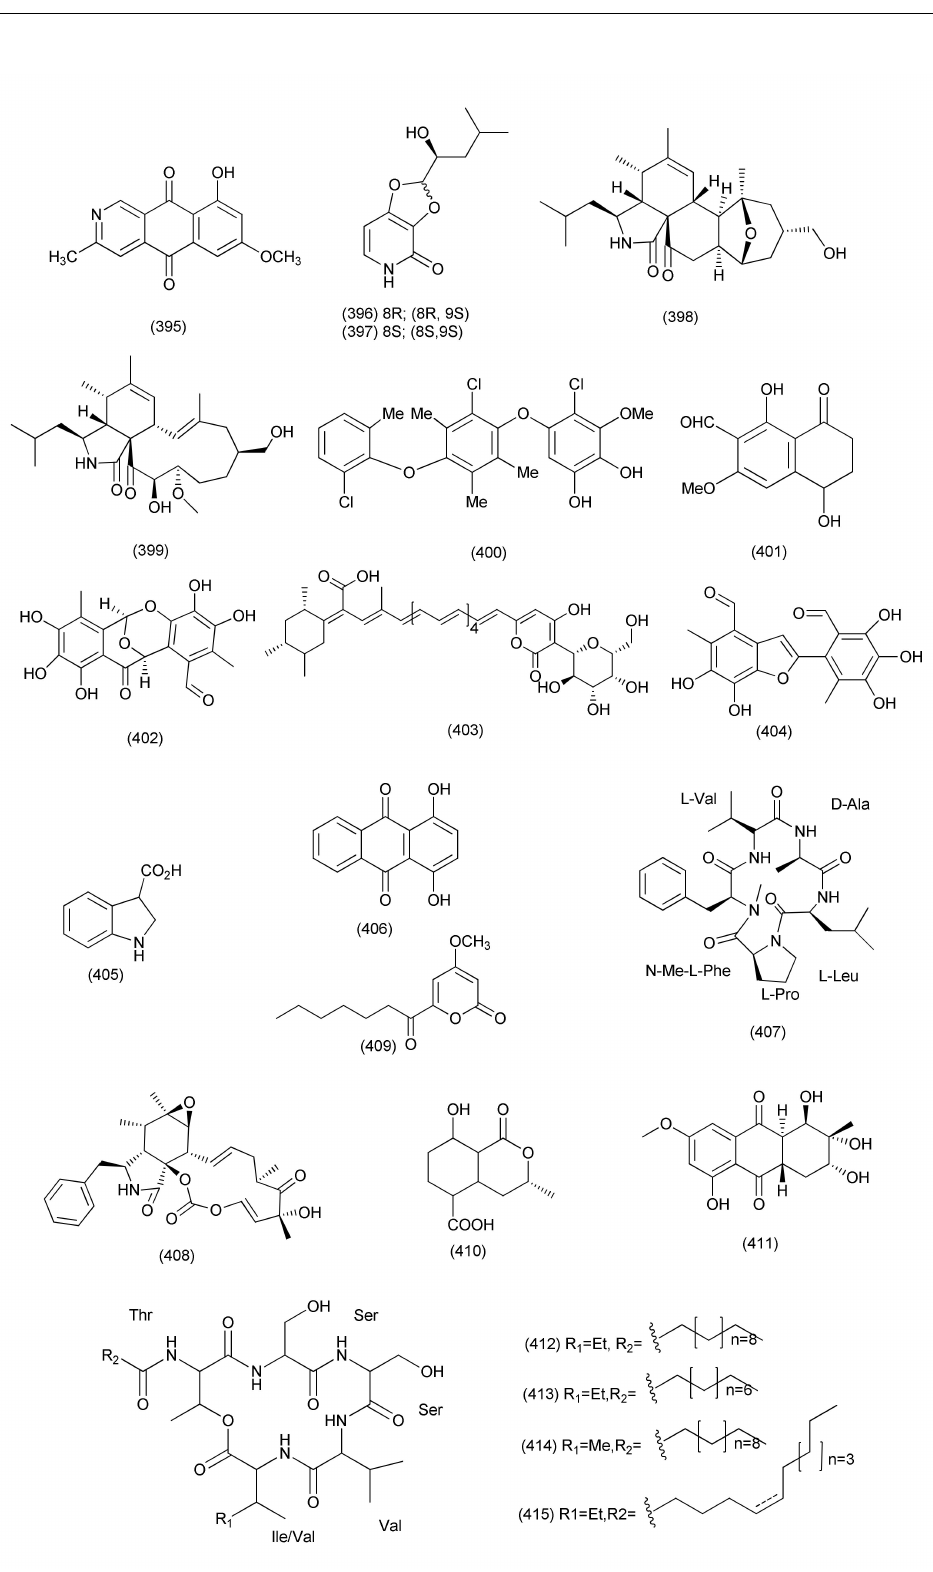
Figure 22. Structures of metabolites 395 – 415 isolated from Minor Anamorphic Ascomycetes. An endophytic fungus Lecanicillium sp. (BSNB-SG3.7 Strain) associated with Sandwithia guyanensis yielded stephensiolides I ( 412 ), D ( 413 ), G ( 414 ), and stephensiolide F ( 415 , Figure 22). Compounds 412 – 415 displayed anti-MRSA activity with MIC values of 4, 32, 16 and 32 µ g/mL, respectively